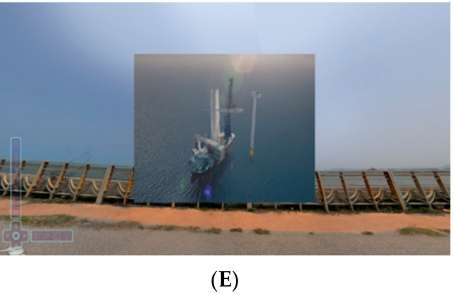
Figure 12. Embedded videos in the same order as Table 5 for illustrating the issues related to wind farm knowledge. ( A ) Station A (video source from https://youtu.be/4Ha5vSlpW2w, accessed on 29 March 2022); ( B ) Station B (video source from https://youtu.be/DILJJwsFl3w, accessed on 29 March 2022); ( C ) Station C (video source from https://youtu.be/B4jEFPdUiMs, accessed on 29 March 2022); ( D ) Station D (video source from https://youtu.be/QK1hr_xCa_4, accessed on 29 March 2022); ( E ) Station E (video source from https://youtu.be/xKYClcExkMY, accessed on 29 March